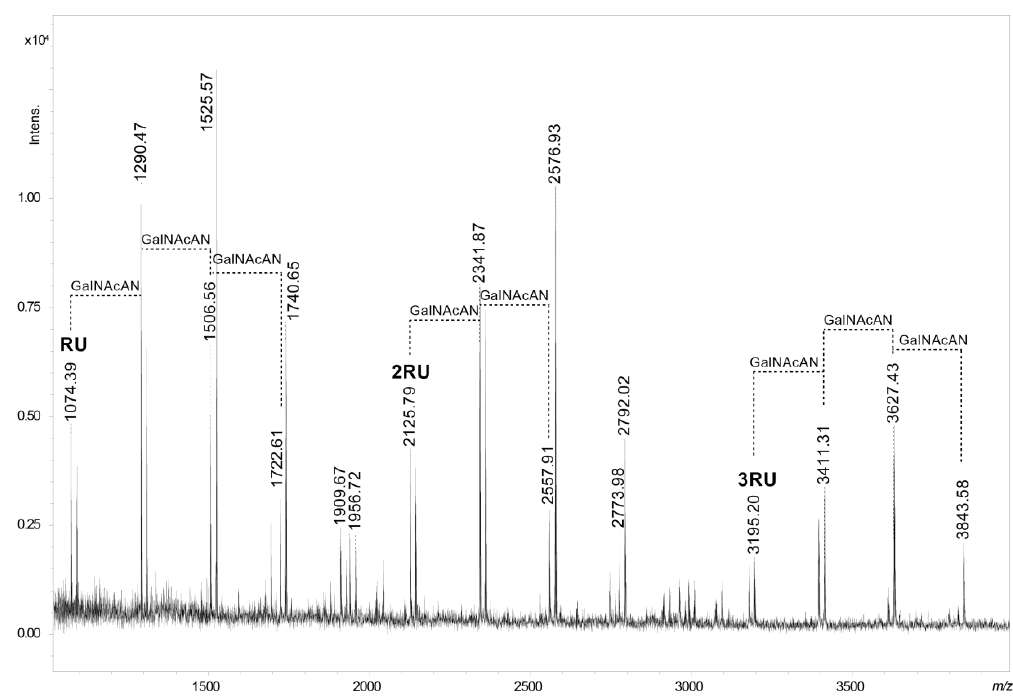
Figure 4. MALDI-TOF mass spectrum in positive ion mode of the partially hydrolysed O-specific polysaccharide (fraction 1) isolated from LPS of P. shigelloides 90/89. The m/z values represent single charged ions. The RU symbol stands for the one repeating unit of the O-specific polysaccharide, as shown in Figure 1b. Mass differences of GalNAcAN are indicated in the spectrum. Table 3. Interpretation of the positive ion mode MALDI-TOF mass spectrum of the partially hydrolysed O-specific polysaccharide fraction isolated from P. shigelloides 90 / 89 LPS (fraction 1). Oligosaccharide Structure